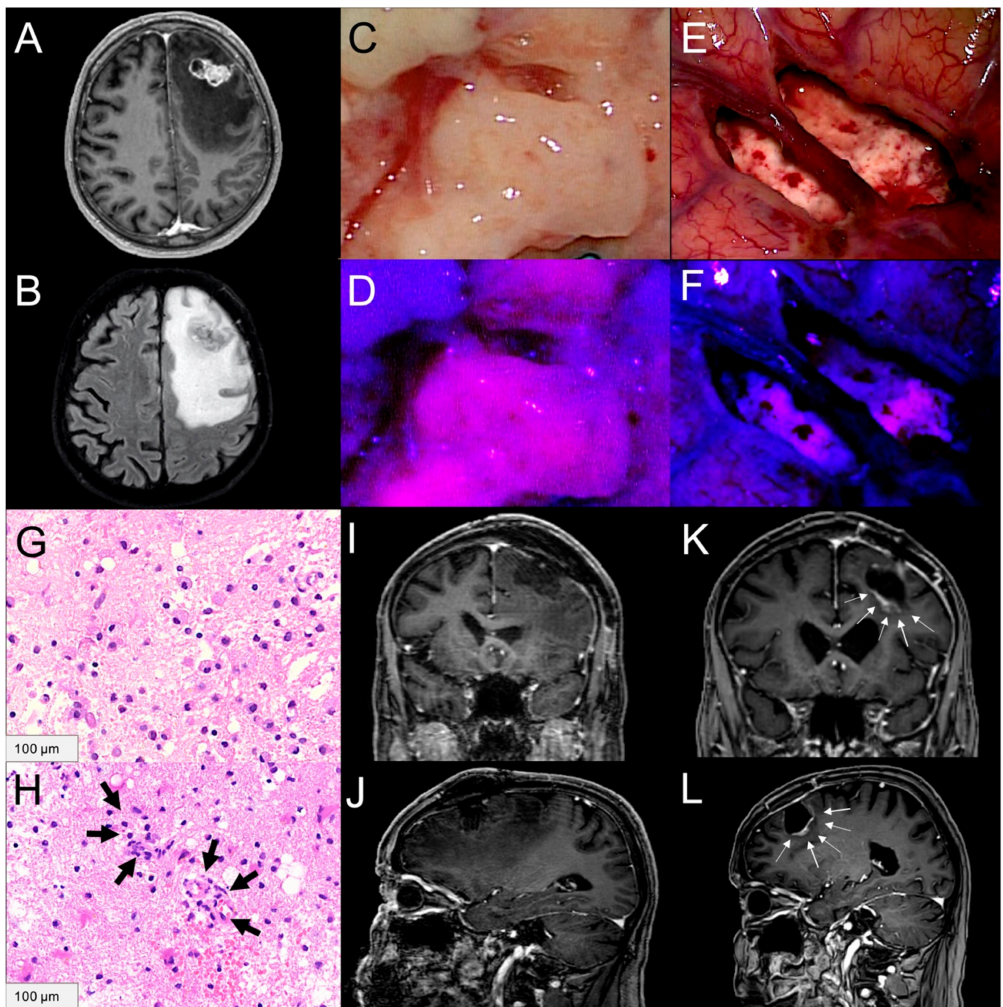
Figure 3. Illustration of fluorescence characteristics, corresponding tumor cell infiltration/angiogenesis and follow-up in a patient with known bladder cancer with surgery of a brain metastasis in the left frontal lobe after preoperative 5-ALA administration. ( A ) The brain metastasis shows heterogeneous contrast-enhancement on T1-weighted images ( B ) with a distinct peritumoral edema. ( C ) During surgery, the brain metastasis is visible under conventional white-light microscopy and ( D ) demonstrates vague 5-ALA fluorescence under violet-blue excitation light. ( E ) After complete tumor resection under white-light microscopy, ( F ) visible fluorescence is detected in the peritumoral brain tissue. ( G ) According to histopathological analysis no tumor cell infiltration is present in the peritumoral brain tissue, ( H ) but presence of angiogenesis (black arrows) is detected. ( I ) Postoperative MRI with coronal and ( J ) sagittal sequences confirms a complete resection without evidence of residual tumor. ( K ) In the first follow-up MRI a rapid tumor recurrence (white arrows) is detected on coronal and ( L ) sagittal sequences and the patient died 6 months after